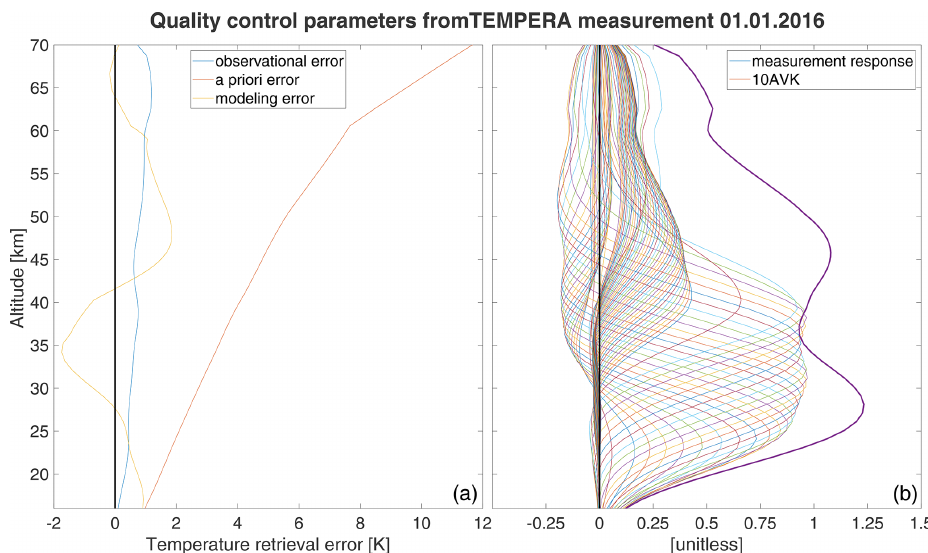
Figure 3. Different error components from the retrieval method (a) . Units of errors are always Kelvin here. Measurement response (MR) and averaging kernel matrix (AVK) (b) . The AVK is multiplied by a factor of 10 for a facilitated comparison with the MR.